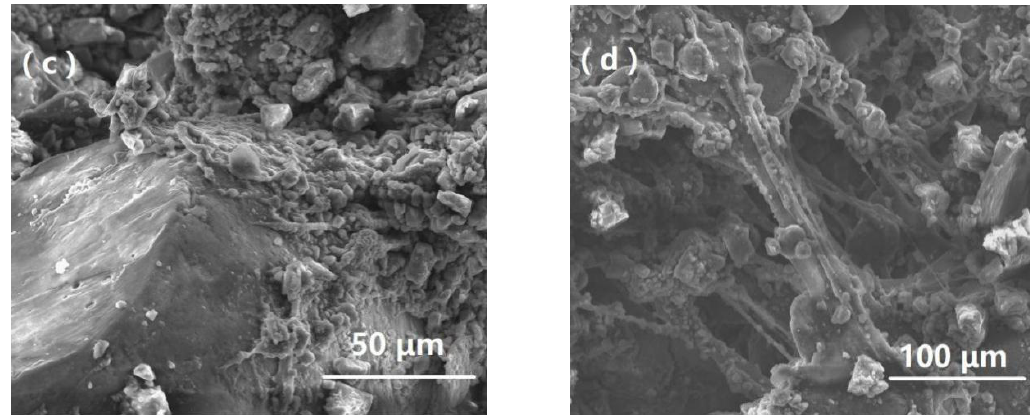
Figure 6. SEM micrographs of the non-fractured H-80W after split Hopkinson pressure bar apparatus (SHPB) testing at room temperature under a strain rate of 2460 s −1 : ( a ) ammonium perchlorate (AP) particles embedding within the HTPB matrices as well as the distinct interfaces of the particle-binder in an untested specimen; ( b ) debonding of the particle–binder interface induced by impact loading; ( c ) the unbroken AP particle with covering residual binder polymer; ( d ) the strip-shape polymer caused by severe binder matrix tearing.